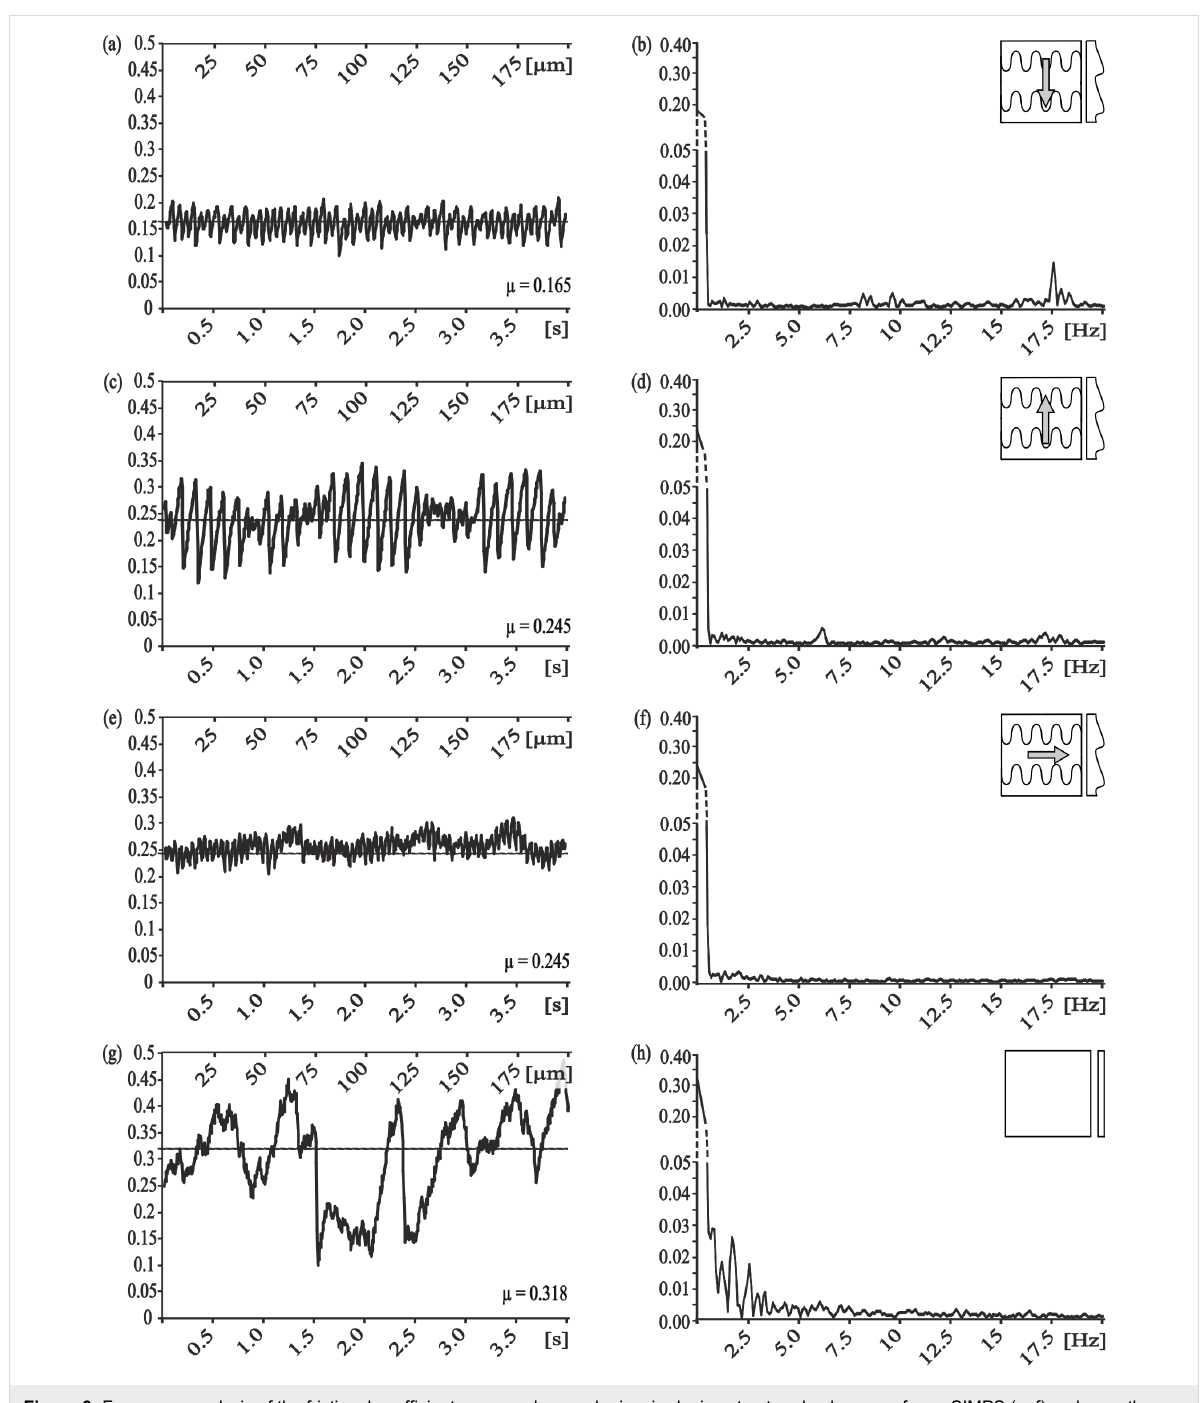
breaking of contact, which can be a source for discrete occur- ring oscillations and thereby specific frequencies within a fric- tional signal. By optimizing the dimensions of the microstruc- ture and specific vibrations induced in this way, this could be a